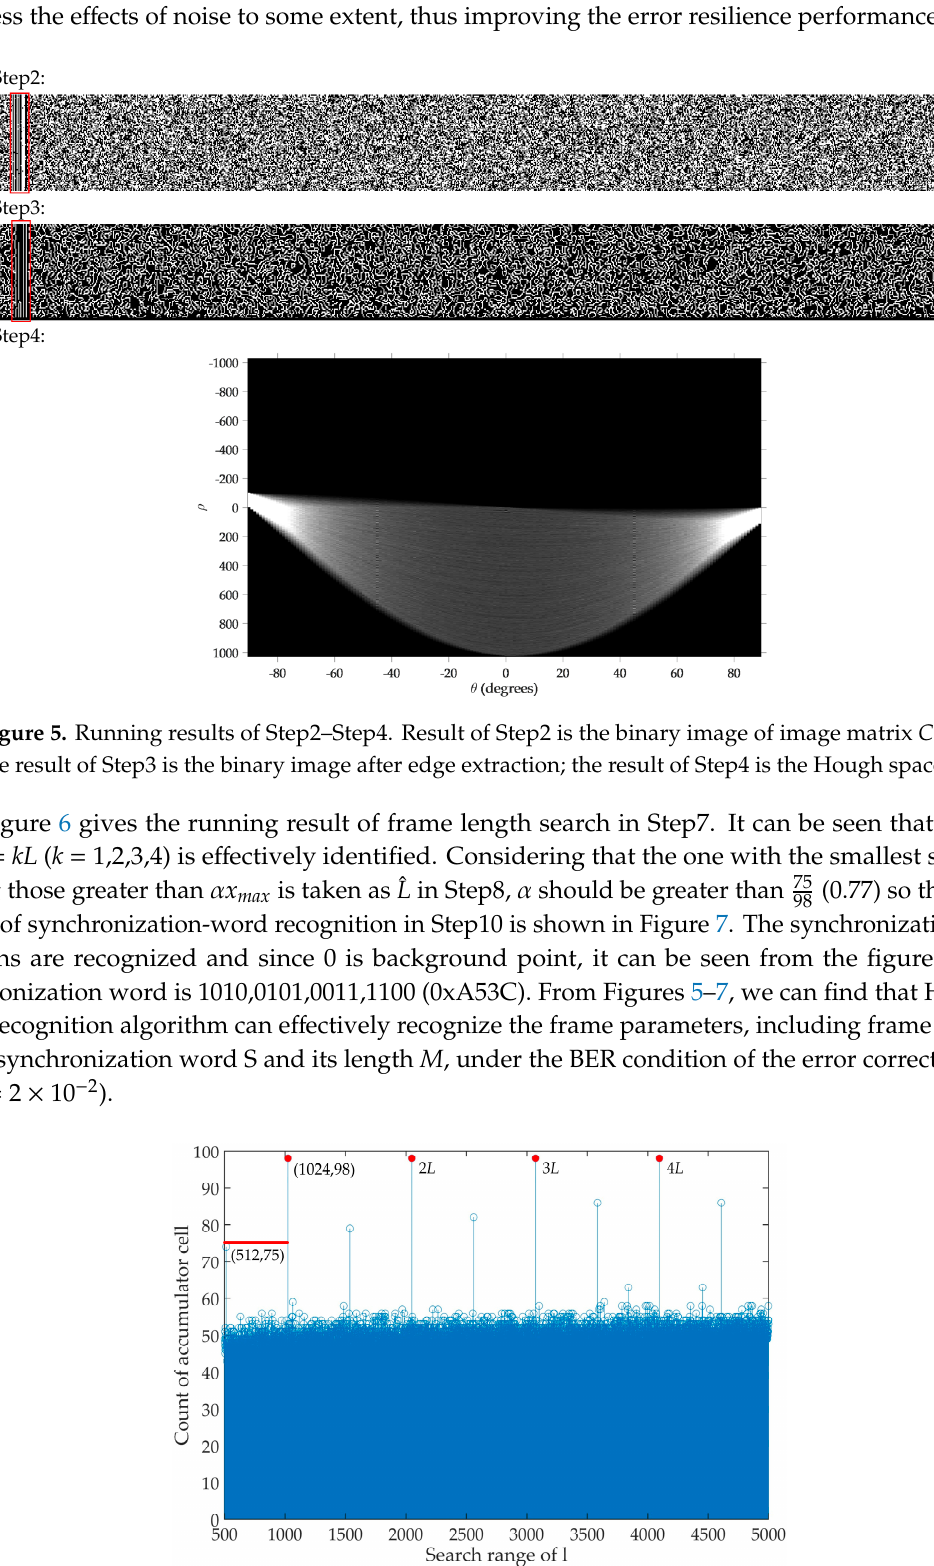
Figure 6. Result of frame length search in Step7. ( l ∈ [500,5000] and L = 1024)